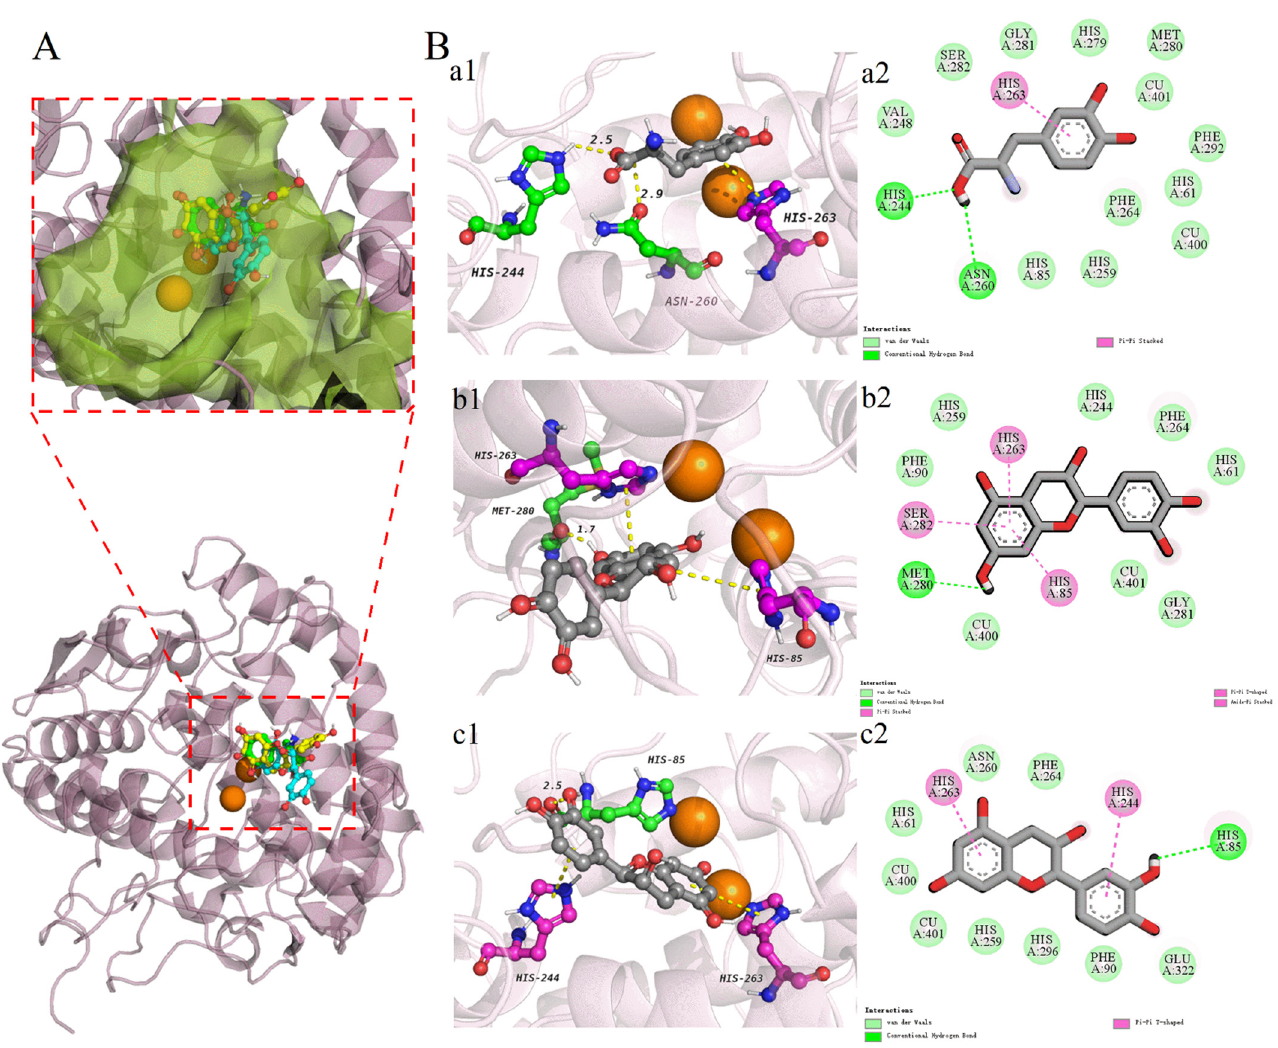
Figure 6. Molecular docking results of L-DOPA, (+)-catechin and ( − )-epicatechin with tyrosinase active proteins. ( A ) is the pocket position of the three compounds bound to tyrosinase. Three-dimensional conformation diagrams of L-DOPA ( Ba1 ), (+)-catechin ( Bb1 ) and ( − )-epicatechin ( Bc1 ) forming different forces with tyrosinase. ( Ba2 , Bb2 , Bc2 ) are two-dimensional conformation diagrams of hydrogen bonds, van der Waals forces and π -bonds formed by the three compounds with tyrosinase, respectively.